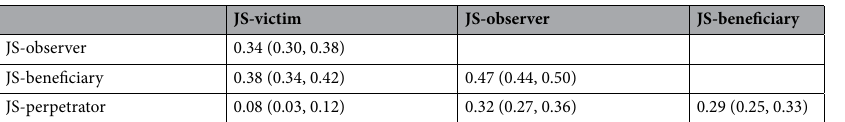
Table 2. Phenotypic correlation matrix for the four JS facets (with 95% CIs). All correlations are significant at p <